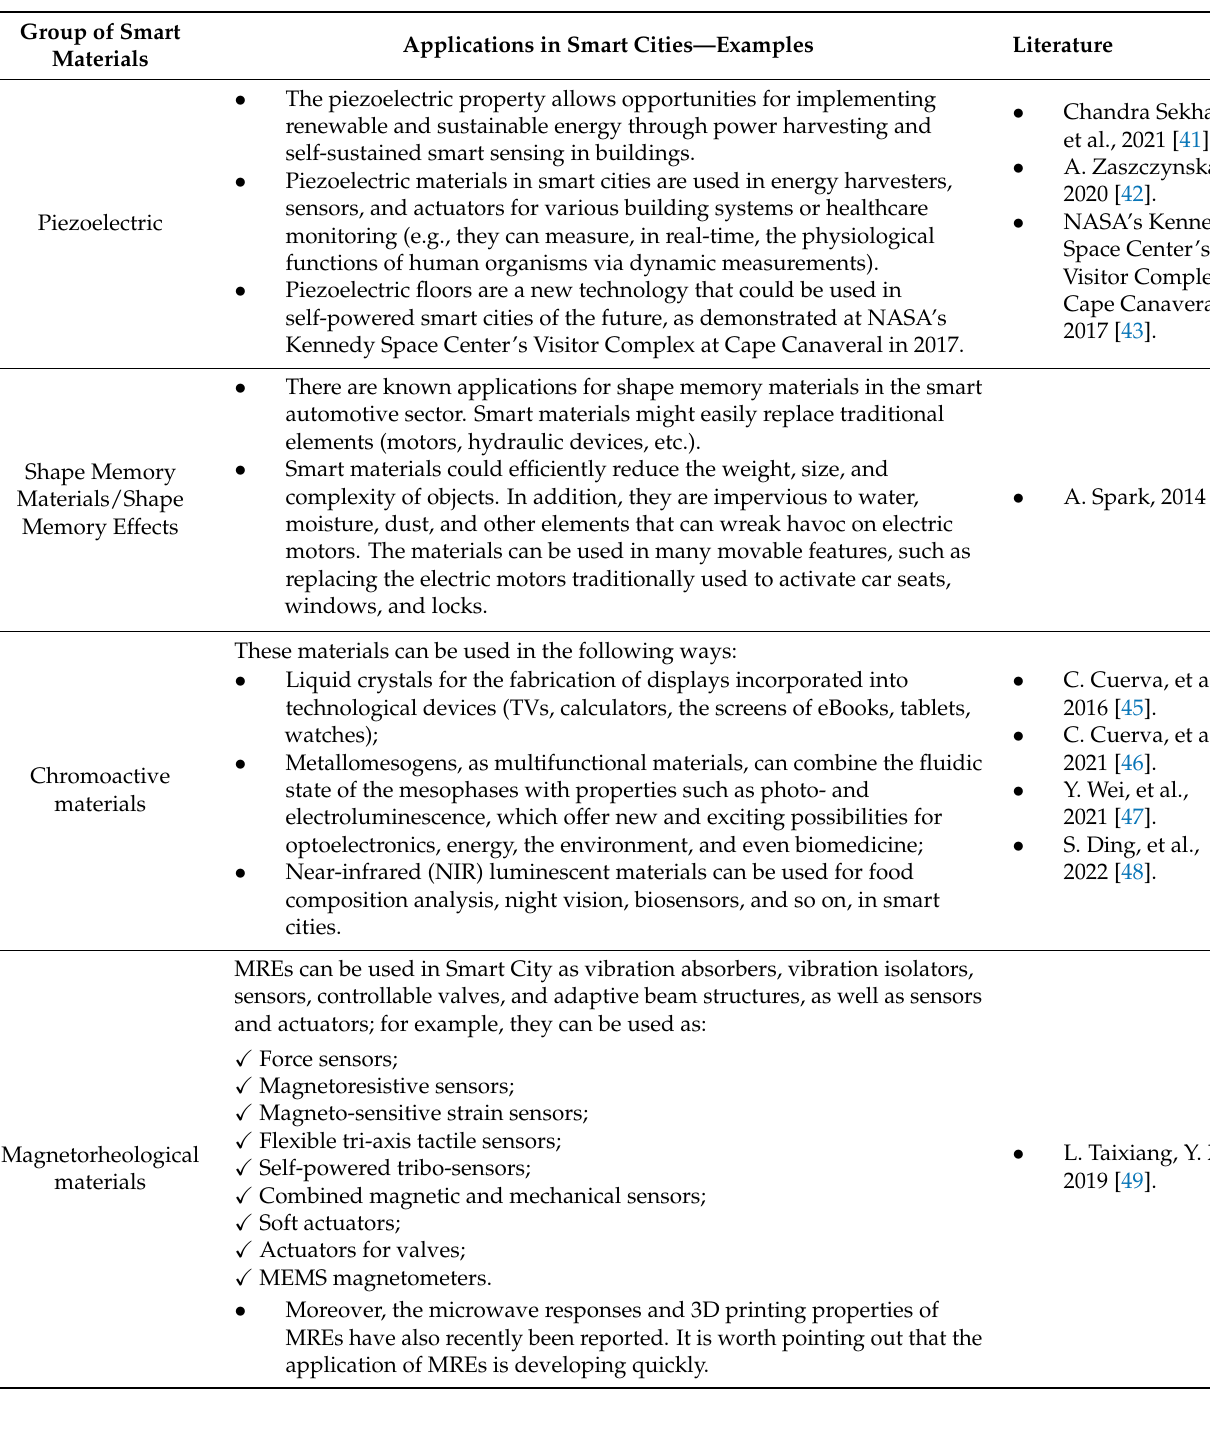
Table 2. Smart materials in smart